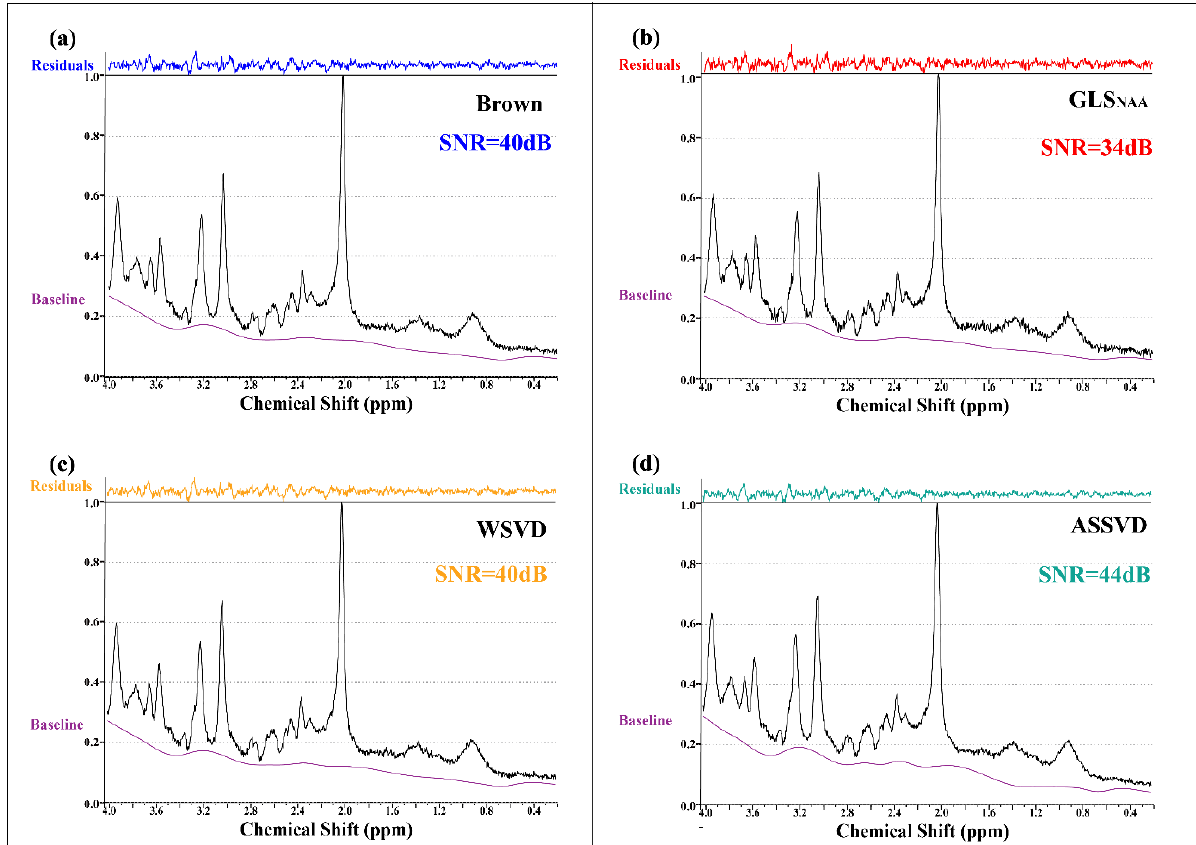
Figure 6. In vivo MRS coil-combined results. ( a ) Brown, ( b ) GLS using NAA peak as the reference, ( c ) WSVD, and ( d ) the proposed method ASSVD. The black and purple lines represent coil-combined MRS x and the baseline x baseline estimated by LCModel, respectively. Additionally, the residuals shown at the top were calculated by x − x fitted